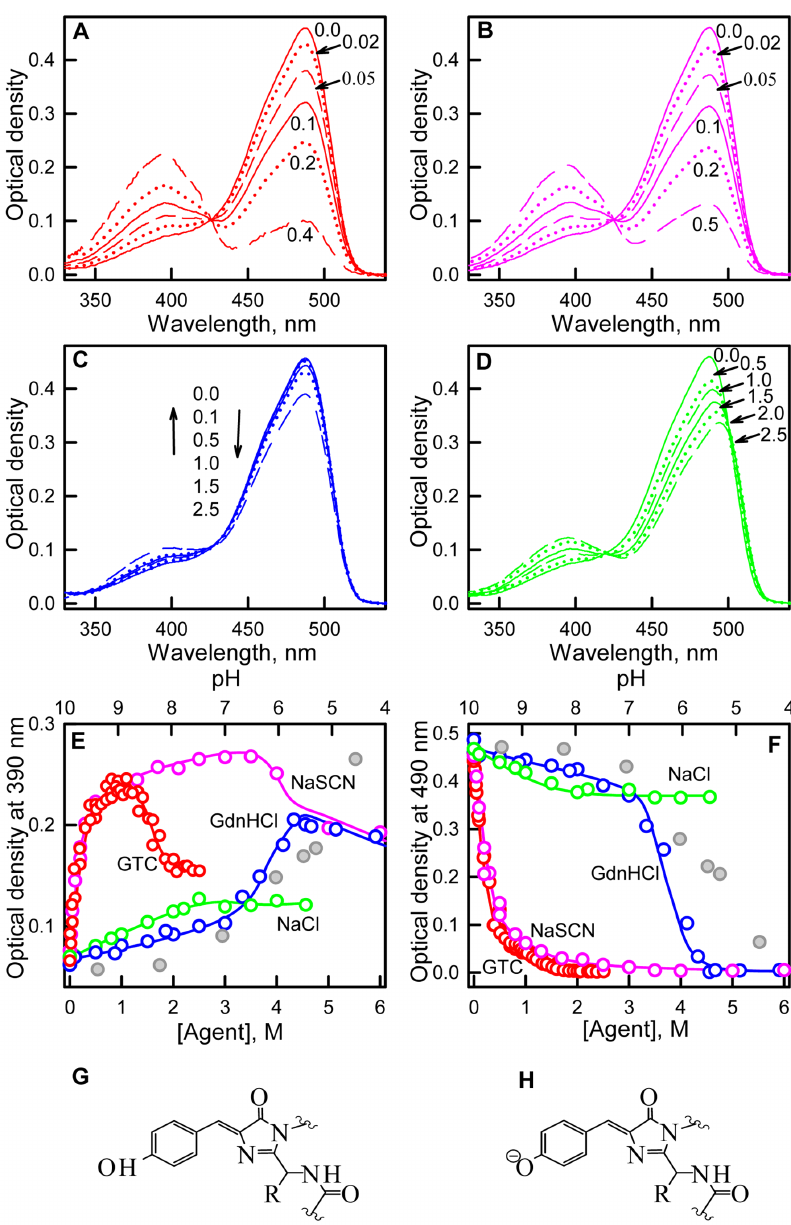
Figure 2. Ionic denaturants and salts effects on absorption of neutral and anionic chromophore forms of sfGFP. ( A ) Absorption spectra of sfGFP in the buffered solution and in the presence of 0.02, 0.05, 0.1, 0.2 and 0.4 M GTC. ( B ) Absorption spectra of sfGFP in the buffered solution and in the presence of 0.02, 0.05, 0.1, 0.2 and 0.5 M NaSCN ( C ) Absorption spectra of sfGFP in the buffered solution and in the presence of 0.1, 0.5, 1.0, 1.5 and 2.5 M GdnHCl. ( D ) Absorption spectra of sfGFP in the buffered solution and in the presence of 0.5, 1.0, 1.5, 2.0 and 2.5 M NaCl ( E ) Changes in optical density at the absorption maxima for the neutral chromophore. ( F ) Changes in optical density at the absorption maxima for the anionic chromophore. Agents used included ionic denaturants, such as GTC (red circles) and GdnHCl (blue circles), and salts, such as NaSCN (pink circles) and NaCl (green circles). Data on absorption of neutral and anionic chromophore of sfGFP in different pH are shown in gray circles, axis of abscissas for these data is on top. Schematic representation of neutral ( G ) and anionic ( H ) chromophores is given. the equation (7) for sfGFP in buffered solution are 0.22 and 0.78. ratio should be constant in the wavelength range where only one The value of neutral chromophore for sfGFP in buffered solution component absorbs [34]. On the basis of the plots presented in is in good agreement with the value of 0.18 for dark fraction in Figure 5 the wavelengths l 1 was chosen to be equal to 490 nm. sfGFP determined by FCS by Cotlet [35]. Thus, on the basis of According to the assumption on a Gaussian form of absorption a A 0 ð Þ and experimentally determined absorbance at 490 nm the spectrum of neutral form of sfGFP we assigned the wavelengths l 2 ( j ) ~ 1 { a ( j ) can be calcu- as 355 nm which is symmetrical to the isosbestic point l IP at fraction a A j ð Þ and consequently a N A 425 nm. The values of a N 0 ð Þ and a A 0 ð Þ calculated according to lated.